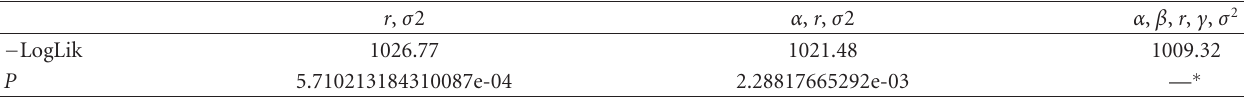
Table 6: Comparison of three models using the likelihood ratio method.